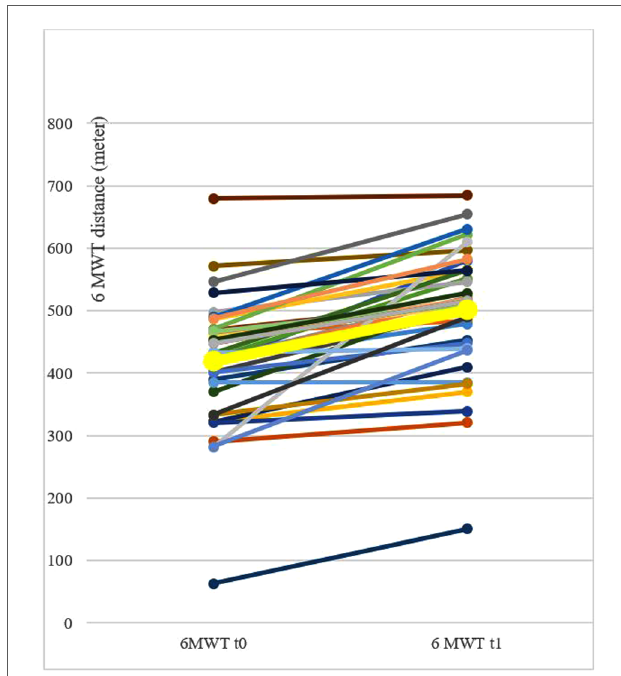
FIGURE 1 Development of 6MWT during rehabilitation of post-COVID patients. Development of 6 Min Walk Test (6MWT) of the single patients during rehabilitation of post-COVID (colored thin lines, n =39) in the beginning (t0) and in the end of the rehabilitation (t1) and mean value (thick yellow